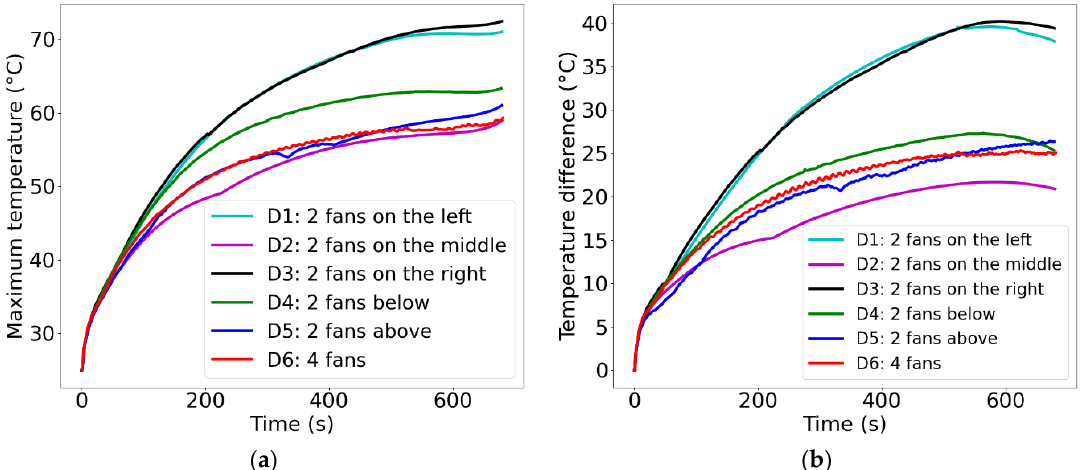
Figure 7. Temperature distribution of the battery module after 5C discharging at an rpm of 2000: ( a ) D1—two fans on the left, ( b ) D2—two fans in the middle, ( c ) D3—two fans on the right, ( d ) D4—two fans on the bottom, ( e ) D5—two fans on the top, and ( f ) D6—four fans.